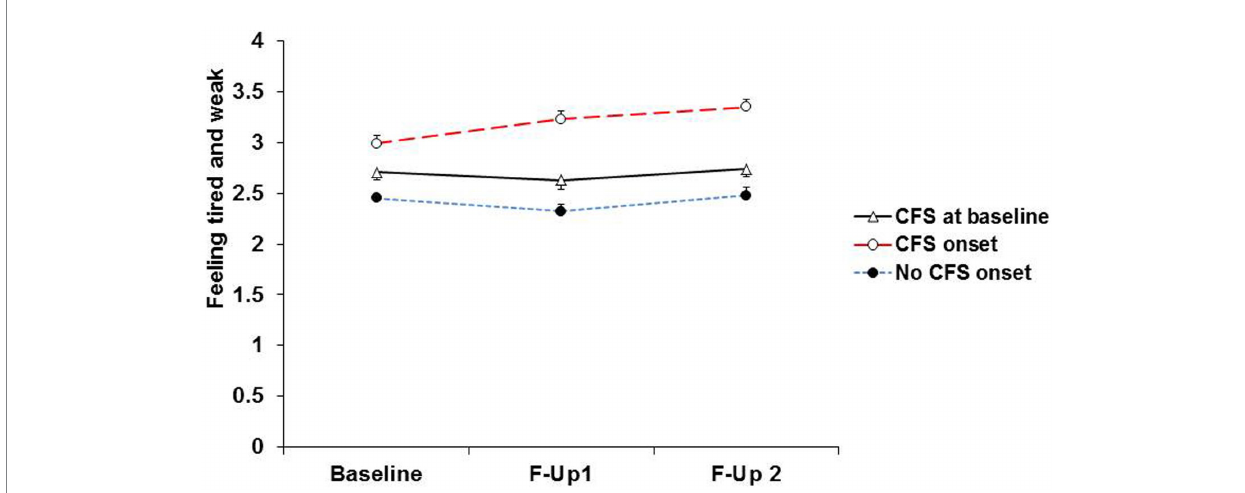
FIGURE 4 Severity of fatigue at baseline, first and second follow-ups in participants with baseline CFS and those without baseline CFS who during follow-up, reported onset of CFS, and did not report onset of